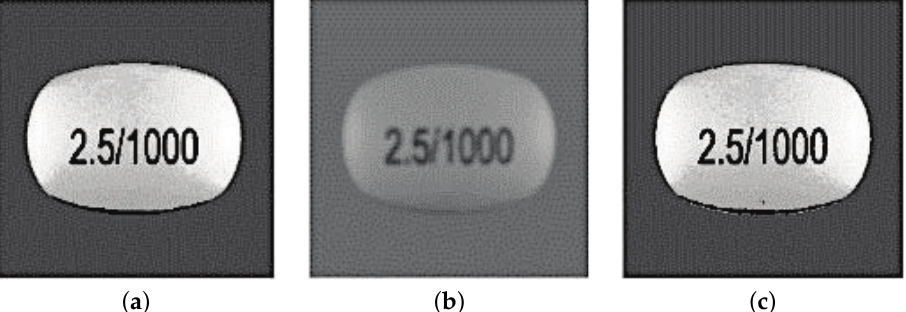
Figure 3. Pill image after applying various filters for color detection: ( a ) Gaussian filter. ( b ) Mean filter. ( c ) Local histogram equalization filter.